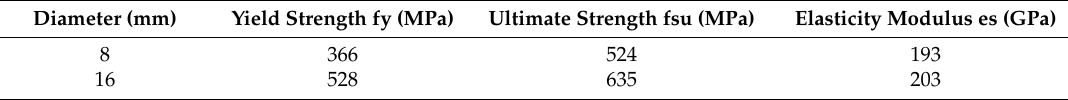
Table 4. Material properties of steel